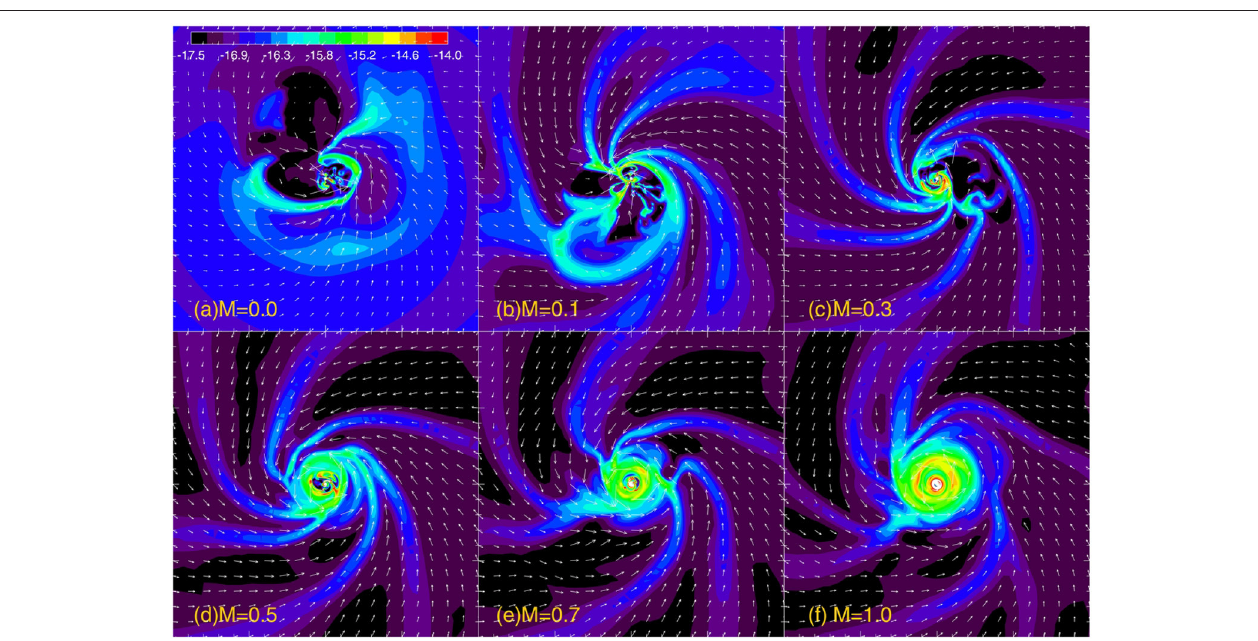
FIGURE 5 | The gas density (color) and velocity (vectors) in the mid-plane for models with increasing Mach number (printed in the bottom left-hand corner of each frame). Each frame is ∼ 1,400 au on each side. In this suite of simulations, increasing the Mach number promotes disc formation. This is Figure 2 of Li et al. (2014). © AAS. Reproduced with